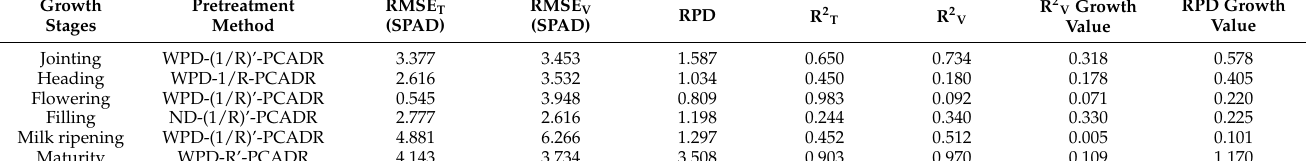
Table 6. The optimal estimation results under the data preprocessing of each growth stages.